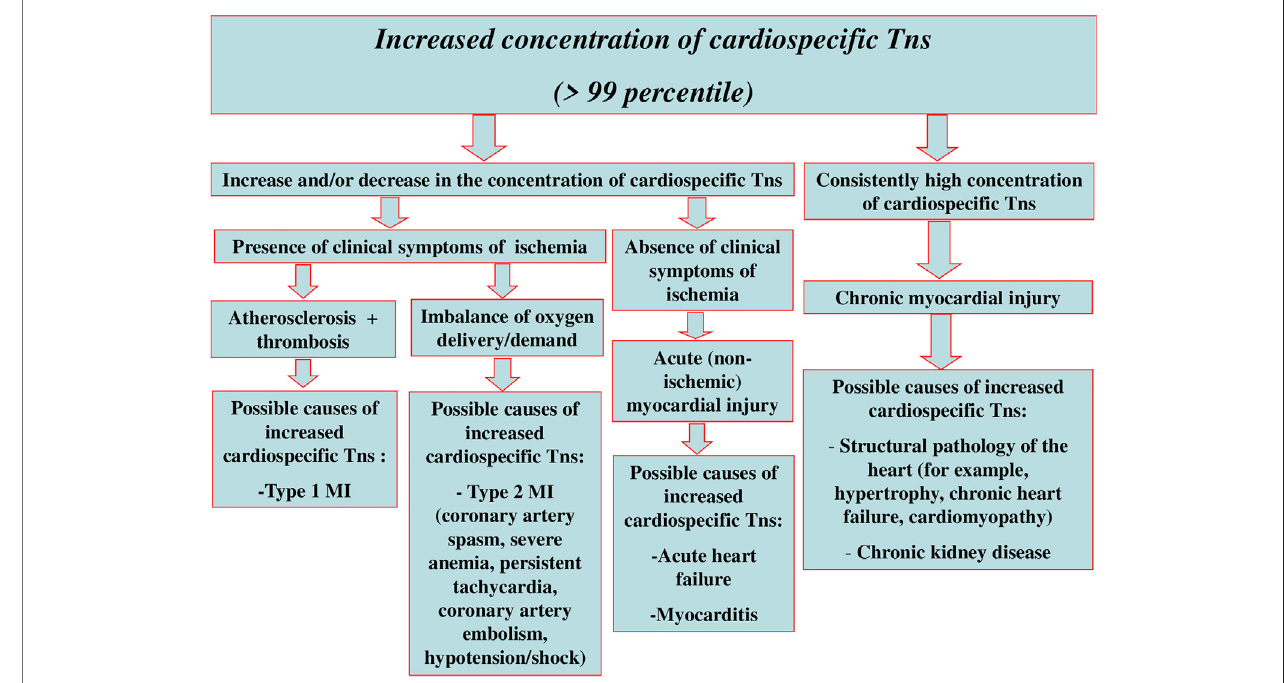
FIGURE 1 | Interpretation of possible reasons for myocardial injury and increase of cardiospeci fi c Tns serum levels.